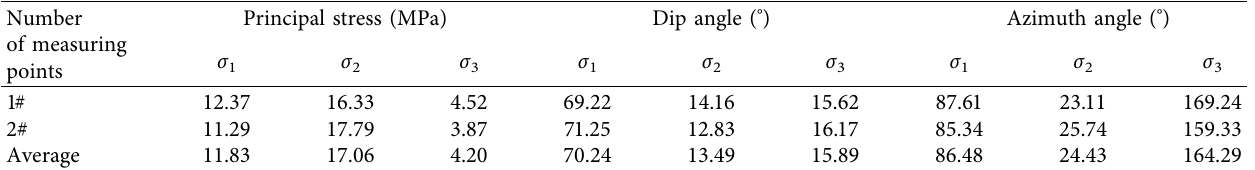
Table 1: Te roadway stress test